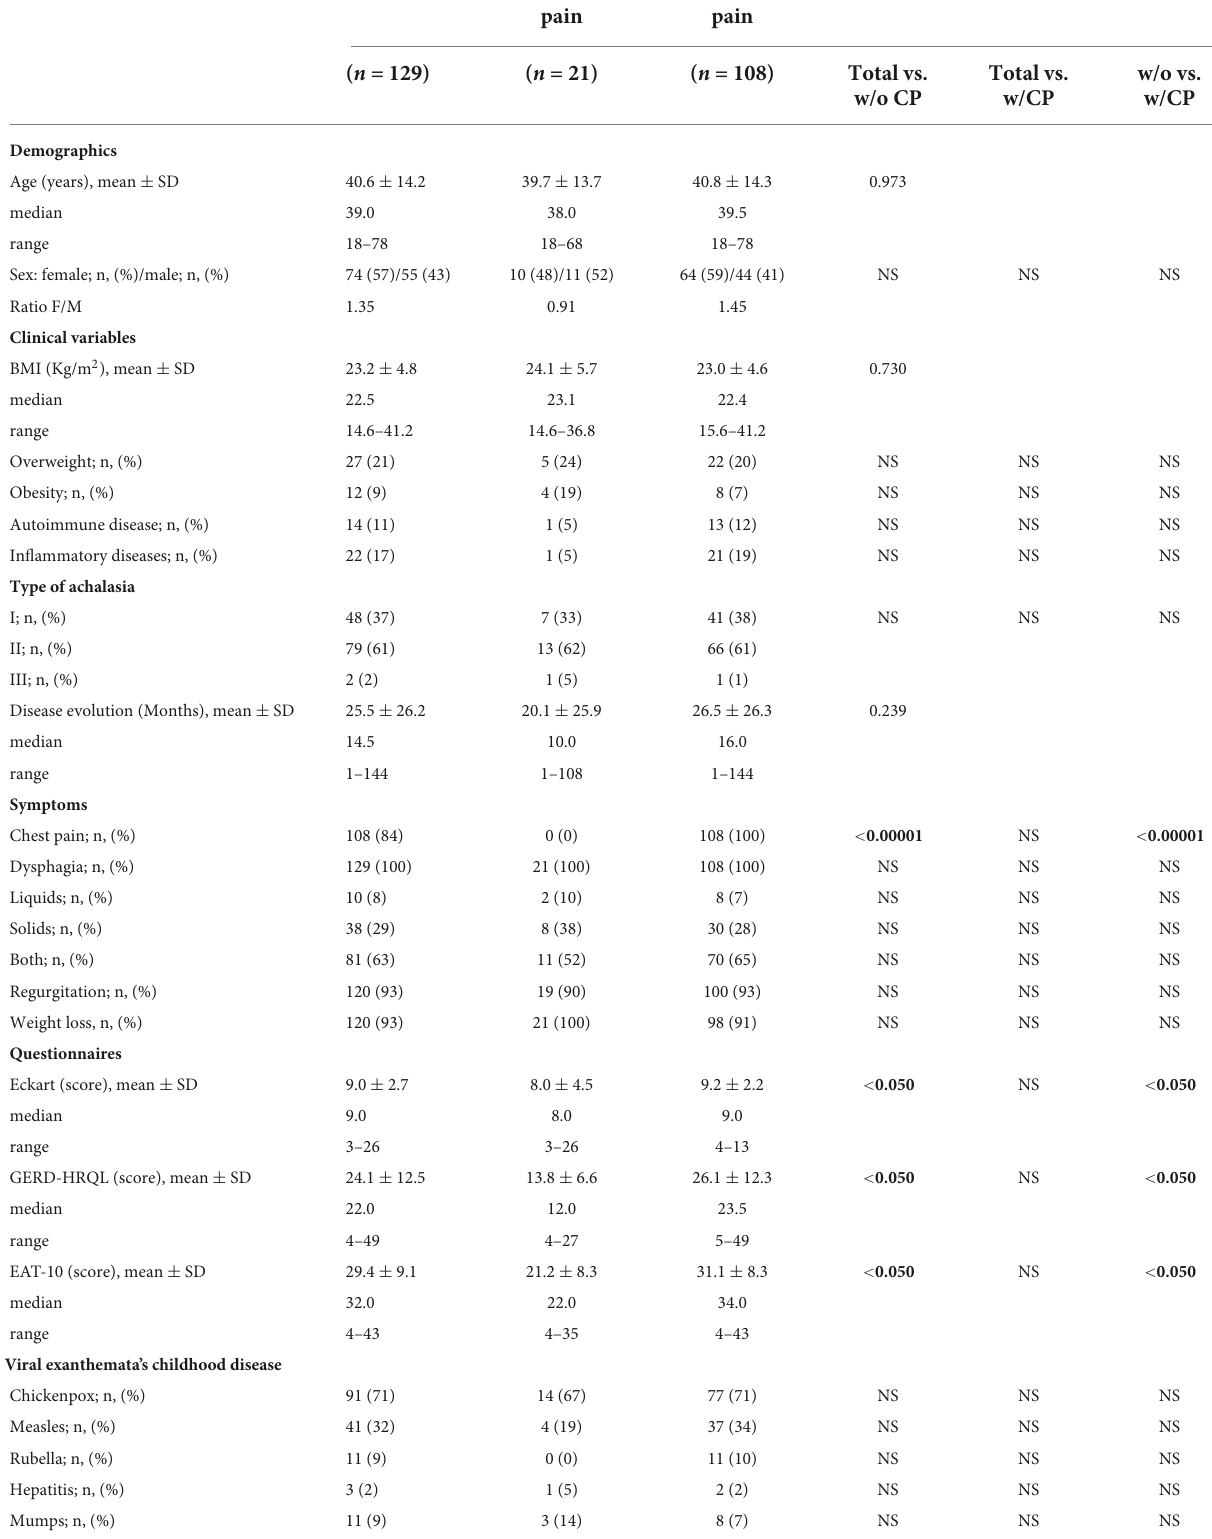
TABLE 1 Presurgical characteristics of the study population according to chest